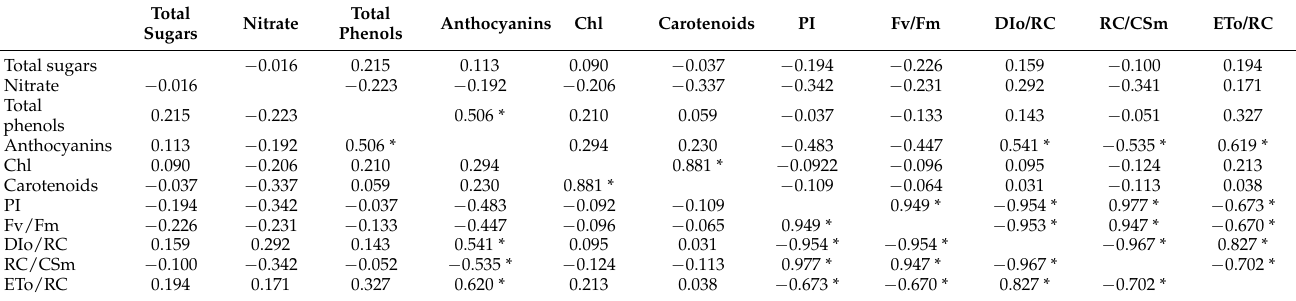
Table 2. Correlation coefficients of all parameters measured and significant correlations is reported with * for p < 0.05.